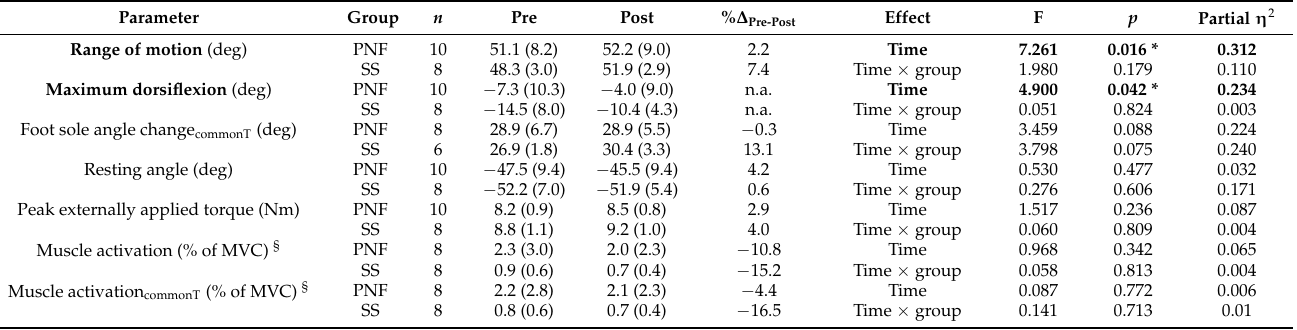
Table 2. Ankle joint range of motion, and peak as well as mean muscle activation measured during dorsiflexion rotations before (pre) and after (post) both acute proprioceptive neuromuscular facilita- tion (PNF) stretching and acute static stretching (SS) in children with spastic cerebral palsy. Data are presented as mean (SD).